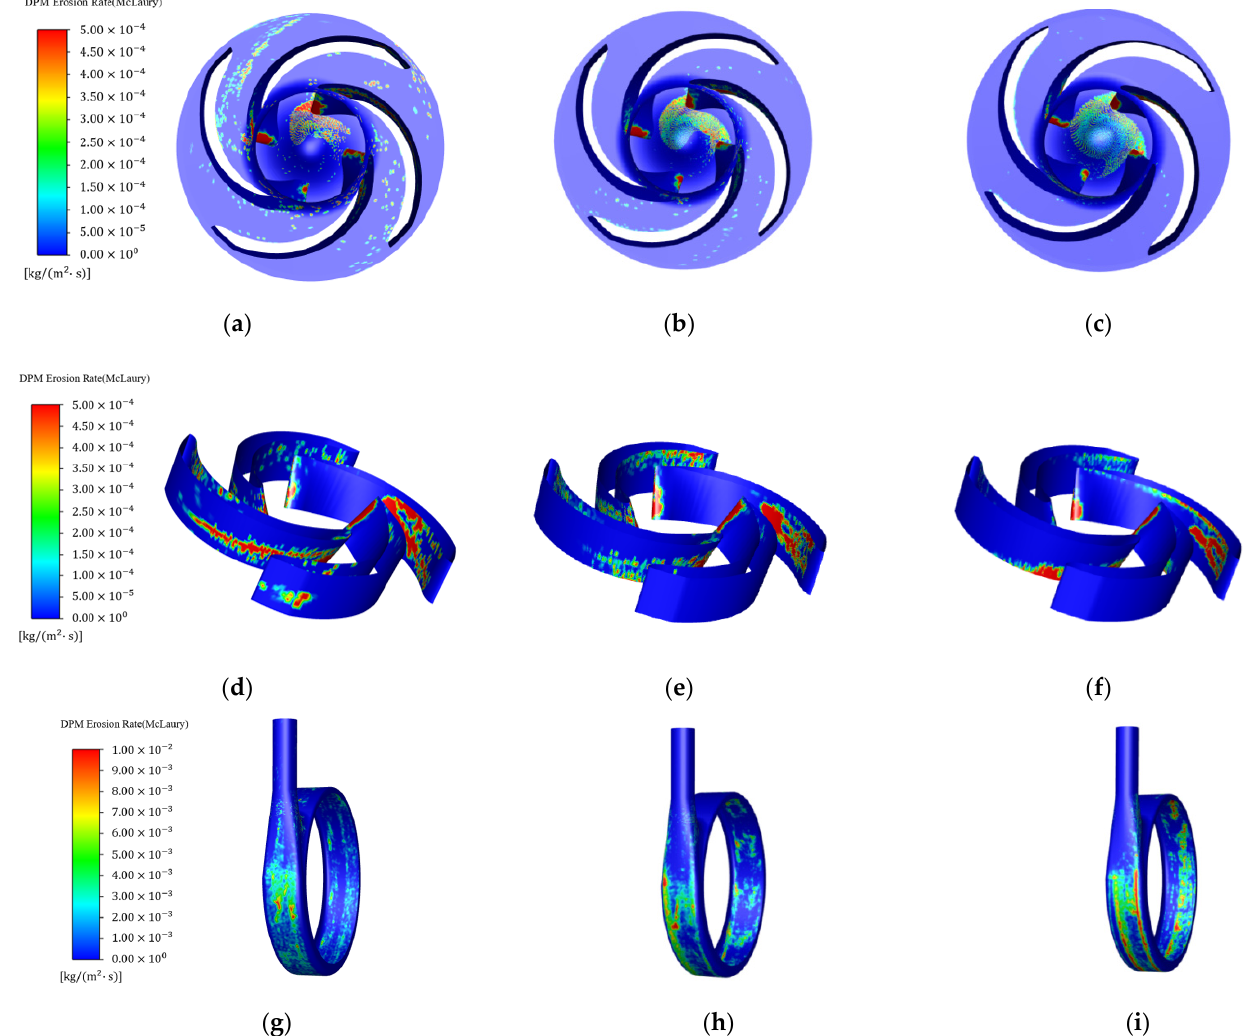
Figure 17. Wear distribution of each part under different particle diameters: Impeller inlet: ( a ) d p = 0.6 mm; ( b ) d p = 0.3 mm; ( c ) d p = 0.15 mm; Blades: ( d ) d p = 0.6 mm; ( e ) d p = 0.3 mm; ( f ) d p = 0.15 mm; Volute: ( g ) d p = 0.6 mm; ( h ) d p = 0.3 mm; ( i ) d p = 0.15 mm.